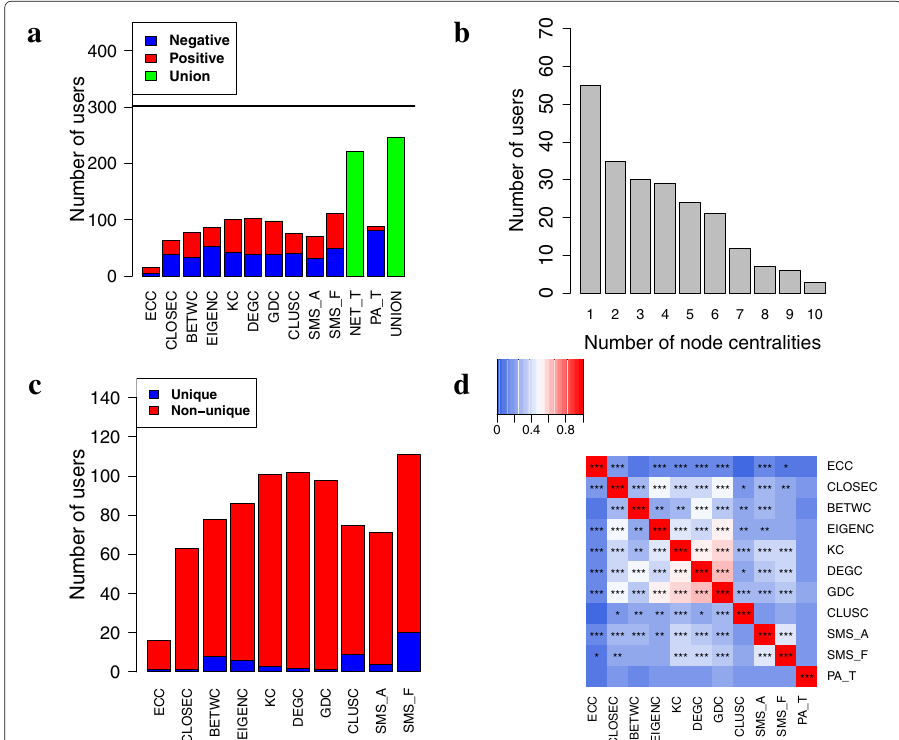
Fig. 7 Results regarding users whose network centralities or physical activities change with time. a The number of significantly-changing users for each of the 10 centralities individually (ECC to SMS_F) or by at least one of them (NET_T), for physical activity (PA_T), and for the union of NET_T and PA_T (the last bar). Red and blue portions of the given bar indicate users that are positively and negatively correlated with time, respectively. b The number of users found by exactly k centralities ( k = 1, 2,..., 10). c The number of users that are unique to the given centrality, i.e., for a given user, only for this centrality, the user’s centrality values significantly change with time. d Pairwise overlaps between significantly-changing users predicted by the different centralities or physical activity. An overlap is measured as Jaccard index, and the resulting overlap size is indicated by the given color. The significance of the overlaps is computed by using the hypergeometric test. *, **, and *** indicate statistical significance at p -value thresholds of 0.05, 0.01, and 0.001,